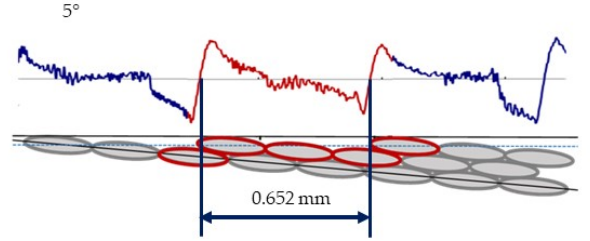
Figure 8. Real ( up ) and theoretical ( down ) profile of the 5° surface.